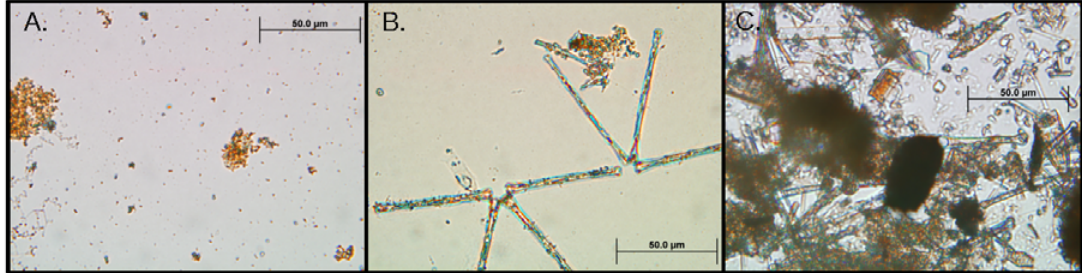
Figure 5. Potential differences in metal forms and ligands for samples from the surface and near ‐ surface water of the upper and lower basins (dehydrated samples): ( A ) upper basin surface water from Burke Canyon above Wallace, Idaho, that contains primarily inorganic metal particles; ( B ) surface water of Thompson Lake at its outlet to the lower Coeur d’Alene River near Harrison, Idaho, that contains metal particles and filamentous algae; and ( C ) porewater from a sediment core collected in Thompson Lake near the outlet to the Coeur d’Alene River that contains oxidized and reduced metal particles/grains and various organic matter. All photos were captured using an SC50 Olympus digital camera on an Olympus BX51 light microscope. All images have 50 ‐μ m scale bars.